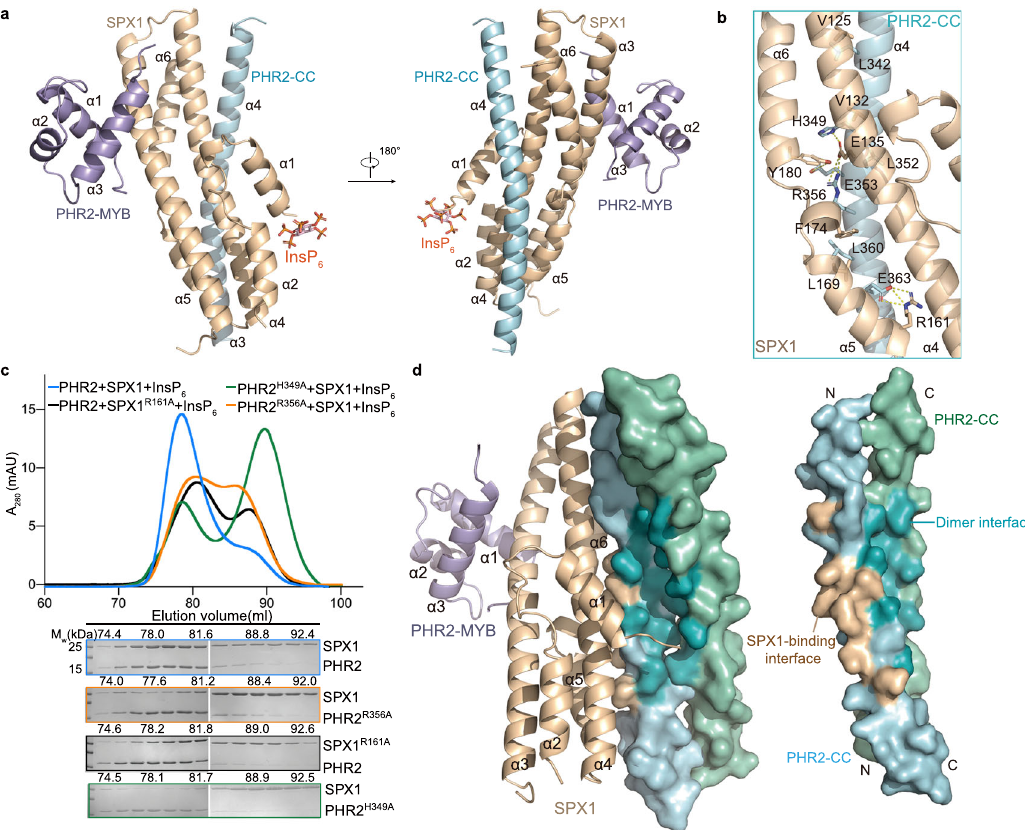
Fig. 2 SPX1-PHR2 CC interface is compatible with PHR2 dimer interface. a The crystal structure of InsP 6 -SPX1-PHR2 complex. SPX1 was colored in wheat, and the MYB and CC domains of PHR2 were colored in light blue and pale cyan respectively. InsP 6 was represented as a stick model in red. InsP 6 - SPX1-PHR2 complex was shown in two opposite views. The secondary structure elements and InsP 6 molecule were labeled. b Close-up view of SPX1-PHR2 CC domain interface. Critical interface residues were shown as sticks and labeled. The yellow dashed lines represent hydrogen bonds involved in the interaction of SPX1 and PHR2. c Mutations compromised the SPX1 1 – 198 -PHR2 248 – 380 complex formation. (Upper) Gel fi ltration pro fi les of SPX1 1 – 198 and PHR2 248 – 380 were color-coded to show different SPX1 1 – 198 mutants and PHR2 248 – 380 mutants. (Lower) Coomassie-blue stained SDS-PAGE gels of peak fractions. Experiments were independently repeated three times with similar results. Uncropped gel images are available as source data. d SPX1-PHR2 CC interface does not interfere with PHR2 dimerization. (Left) Superimposition InsP 6 -SPX1-PHR2-ternary complex structure onto AtPHR1 CC (PDB:6TO5) dimer structure. (Right) Surface representation of rice PHR2 CC dimer model. SPX1-binding interface was colored in wheat and PHR2 dimer interface was colored in